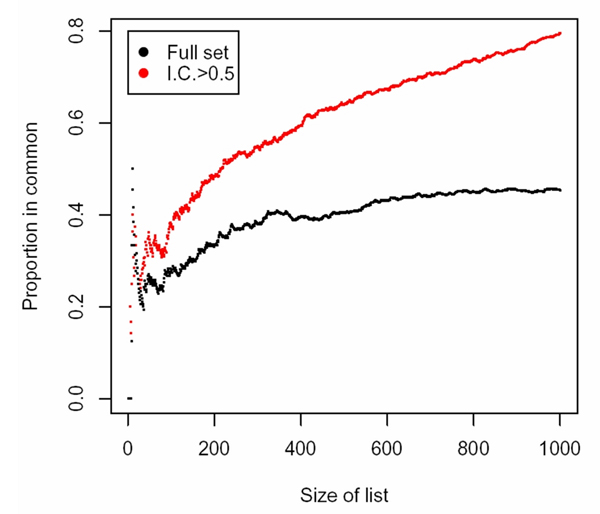
Interplatform agreement. The descriptive CAT (Correspondence At the Top) plots [9] were used to evaluate interplatform agreement. The Correspondence at the top was evaluated for AFFX and ABI using the full set of genes after the IQR filtering step (black line) or after the IC filtering step (red line). For each of the two platforms average |log2 (Fold Change)|, calculated between treatment vs. control group, was used to generate CAT Plots.